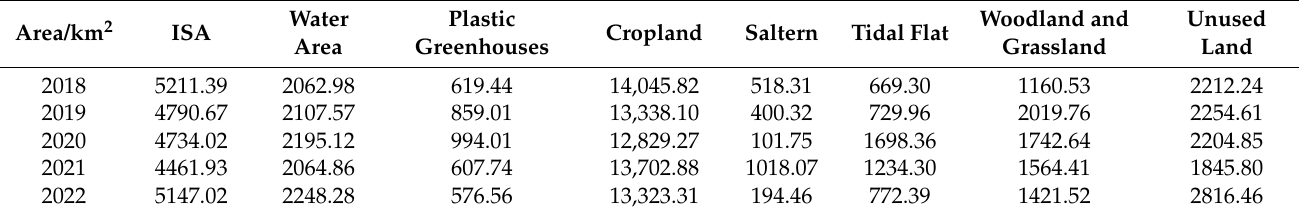
Table 7. Area statistics of different land use/cover types.